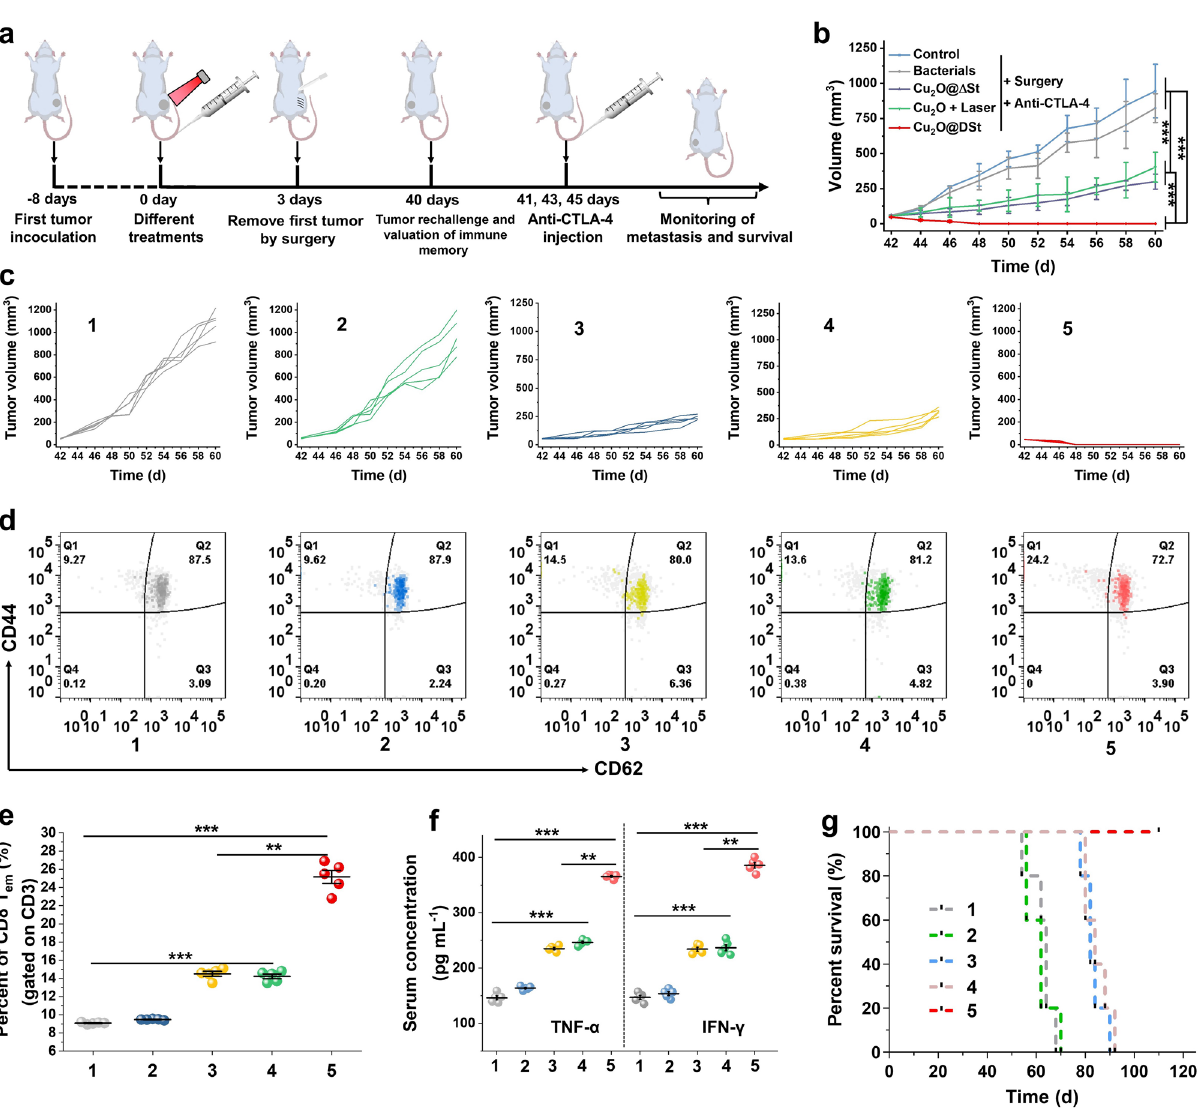
Fig. 7 Long-term immune-memory effects of Cu 2 O@ΔSt. a Schematic illustration of Cu 2 O@ΔSt-based immunotherapy to inhibit cancer relapse. b Volume change curves of rechallenged tumors beyond 40 days after the elimination of their first tumors. c Volume change curves of rechallenged tumor of each mouse after various treatments. d Flow cytometry analysis and e corresponding quantification of the percentage of CD8 + /CD3 + /CD44 + /CD62 − effector memory T cells (T EM ) gated on CD3 + cells in the spleen (spleens were collected on day 40 right before rechallenging mice with secondary tumors). f Cytokine levels of TNF-α and IFN-γ in sera from mice after different treatments. g Morbidity-free survival of different groups of mice after various treatments and subsequent rechallenge by CT26